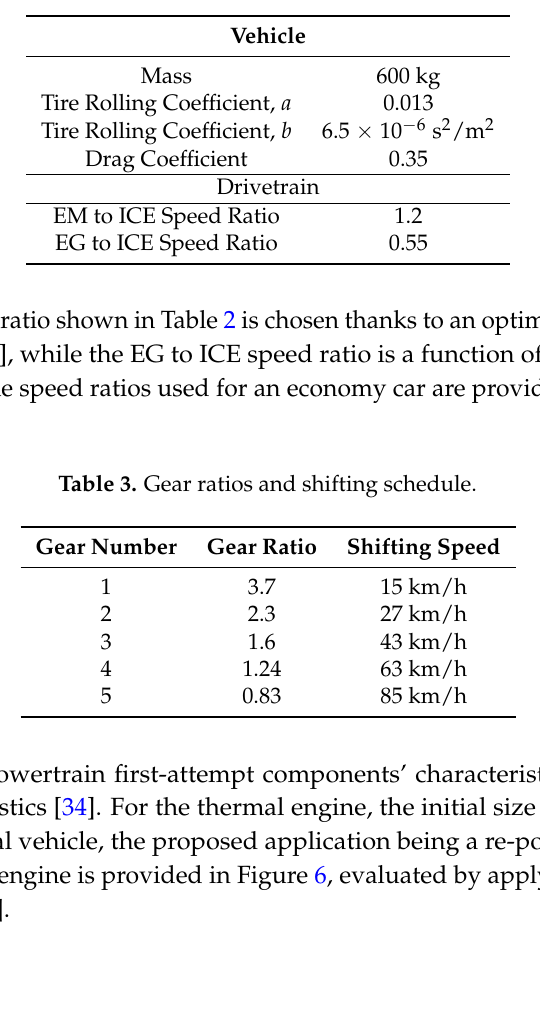
Table 2. Vehicle/drivetrain characteristics.